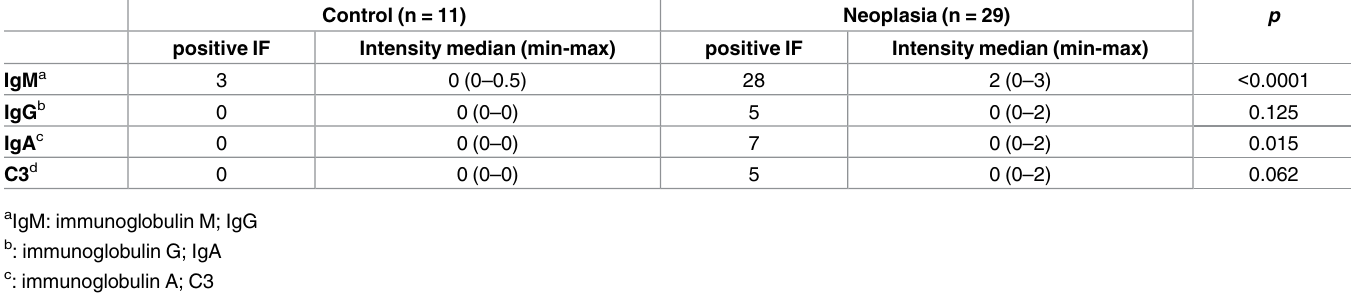
Table 1. Number of dogs that had positive IF labeling with antibodies against canine IgG, IgM, IgA and